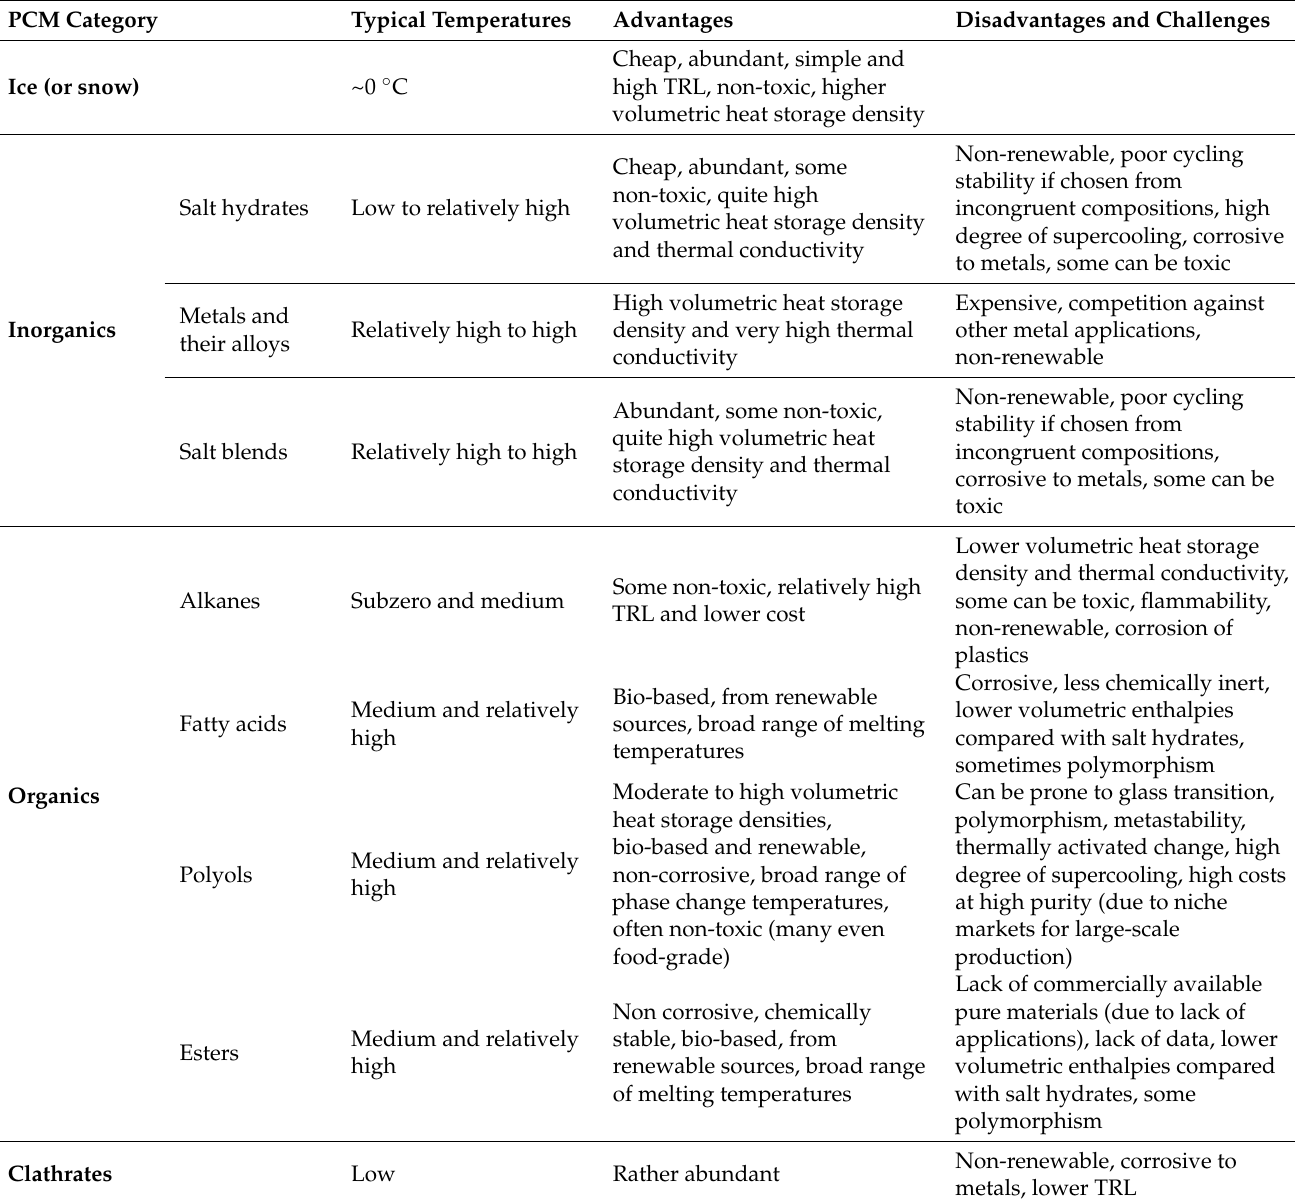
Table 5. Advantages and disadvantages of various PCM categories (here the temperature ranges provided are just indicative but not exclusive. Subzero, low, medium, relatively high, and high temperatures represent below 0 ◦ C, 0–30 ◦ C, ~4–100 ◦ C, ~100–300 ◦ C and above ~300 ◦ C,